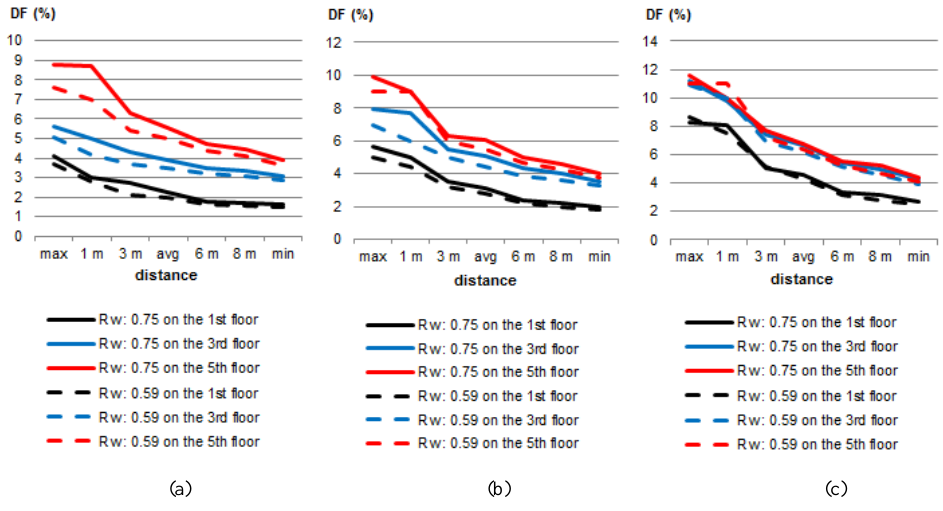
Fig. 8. DF of a 12 m wide room equipped with North-facing windows with light shelves with 2 variations in the wall reflectance in an urban area with 3 variations in aspect ratio, i.e. h / w = 4 and le / L = 0.25 (a), h / w = 2 and le / L = 0.25 (b), h / w = 0.75 and le / L = 0.25